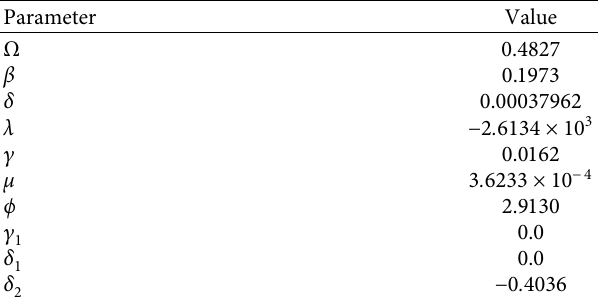
Table 2: Sensitivity indices of the model